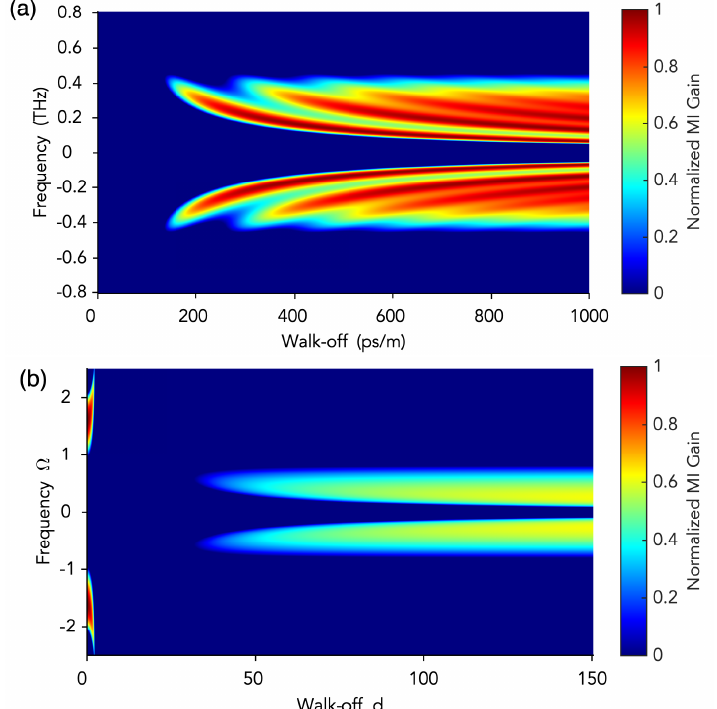
Figure 4. Modulation instability gain profiles as a function of temporal walk-off. ( a ) Singly resonant cavity SHG. ( b ) Doubly resonant cavity SHG (parameters are normalized according to Ref. [51]). Adapted with permission from [50,51]. Copyrighted by the American Physical